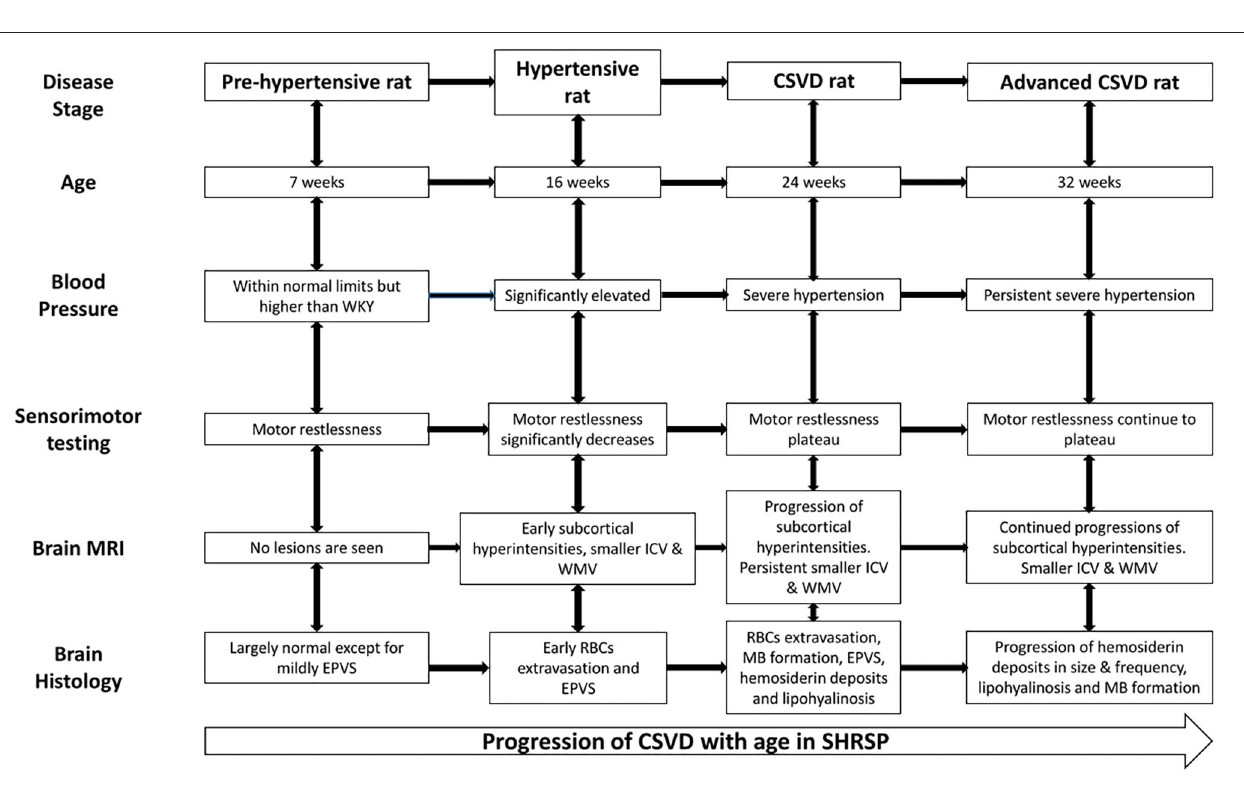
FIGURE 8 | Cerebral small vessel disease (CSVD) stages in SHRSP across age. The pre-hypertensive rat does not show consistent evidence of CSVD except for mildly dilated perivascular spaces but they are restless during the sensorimotor testing. Subsequently, SHRSP develop significant hypertension and they show decrease in restlessness associated with the development of radiographic and histological features of CSVD. The figure details the CSVD correlates at each study time point from the hypertensive rat stage at 16 weeks until the advanced CSVD stage at 32 weeks of age. CSVD, cerebral small vessel disease; EPVS, enlarged perivascular spaces; ICV, intracranial volume; MB, microbleed; RBCs, red blood cell; SHRSP, spontaneously hypertensive stroke-prone rats; WKY, Wistar Kyoto rat; WMV, white matter